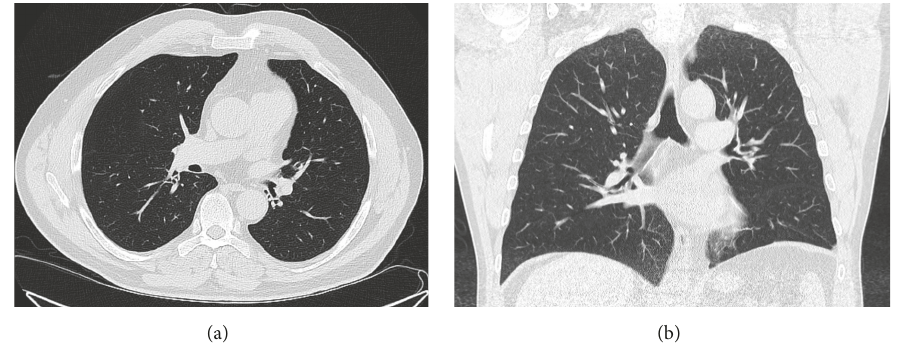
Figure 4: CT scan of the chest (lung window) in horizontal (a) and coronal (b) sections showing a normal lung parenchyma with complete resolution of the left lower lobe infiltrate noted in Figure